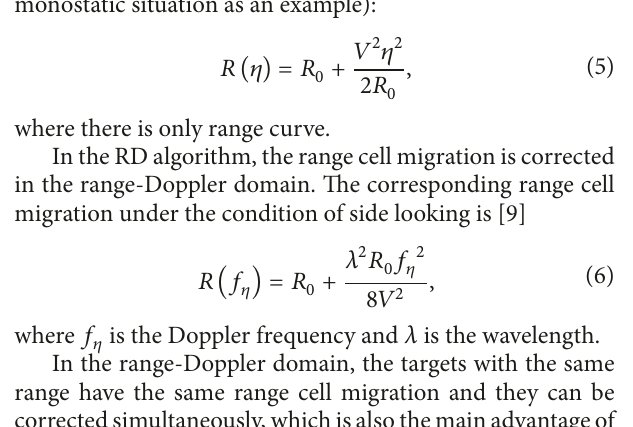
Figure 2: RCMC sketch. The actual curve track must be removed to the location of the nearest slant range 𝑅 0